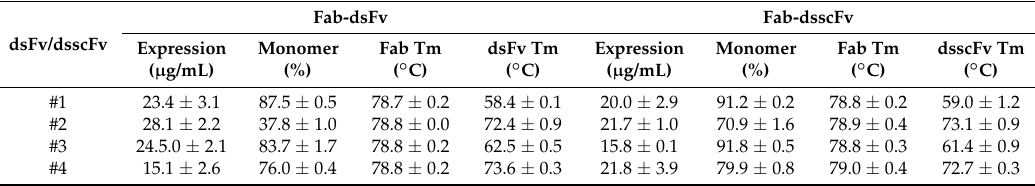
Table 2. Comparison of Fab-dsFv vs. Fab-dsscFv formats. Following the 10-day transient expression in 293F cells, the expression level of Fab-dsFv#1–4 and Fab-dsscFv#1–4 proteins in the culture